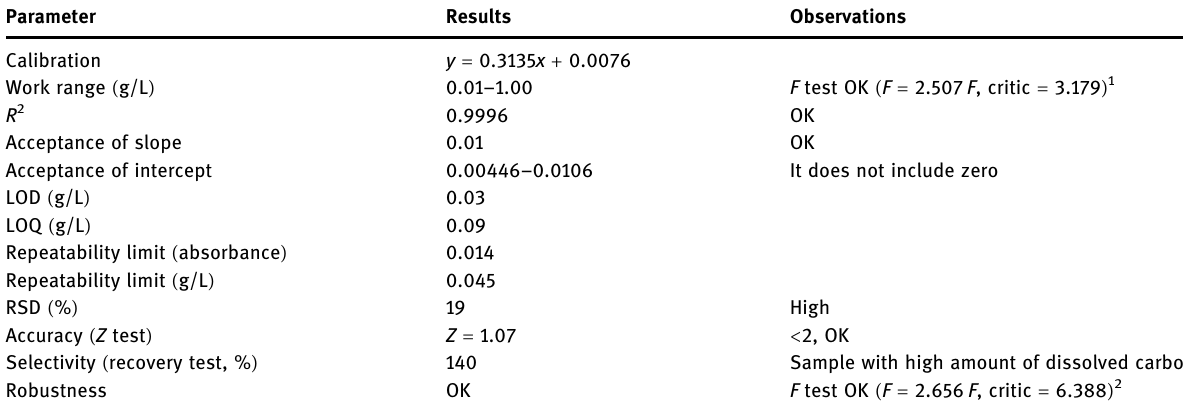
Table 1: Results obtained for the minimum analytical validation requirements Parameter